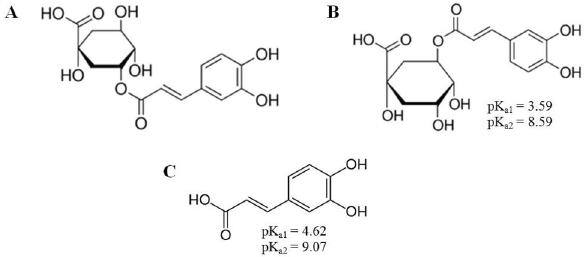
Figure 1. Structure of ( A ) neochlorogenic acid, ( B ) chlorogenic acid and ( C ) caffeic acid; including pKa values determined for the carboxyl group and first phenolic group 45